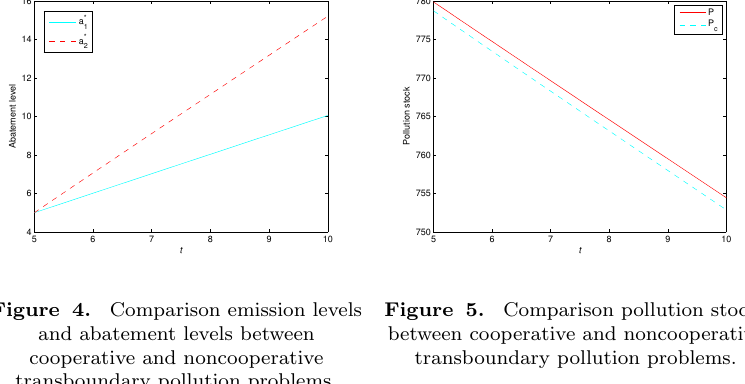
Figure 4. Comparison emission levels and abatement levels between cooperative and noncooperative transboundary pollution problems.